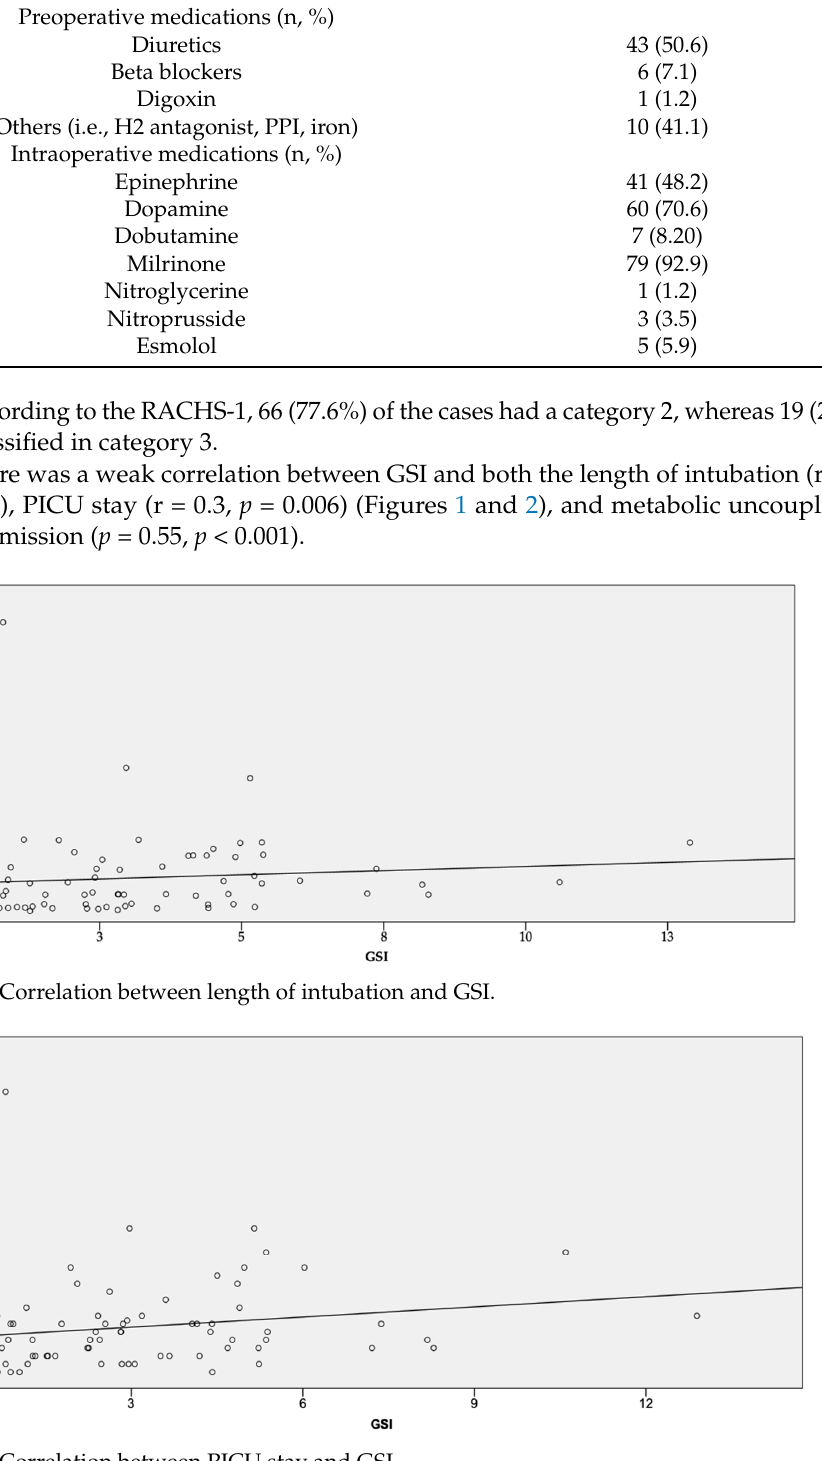
Figure 2. Correlation between PICU stay and